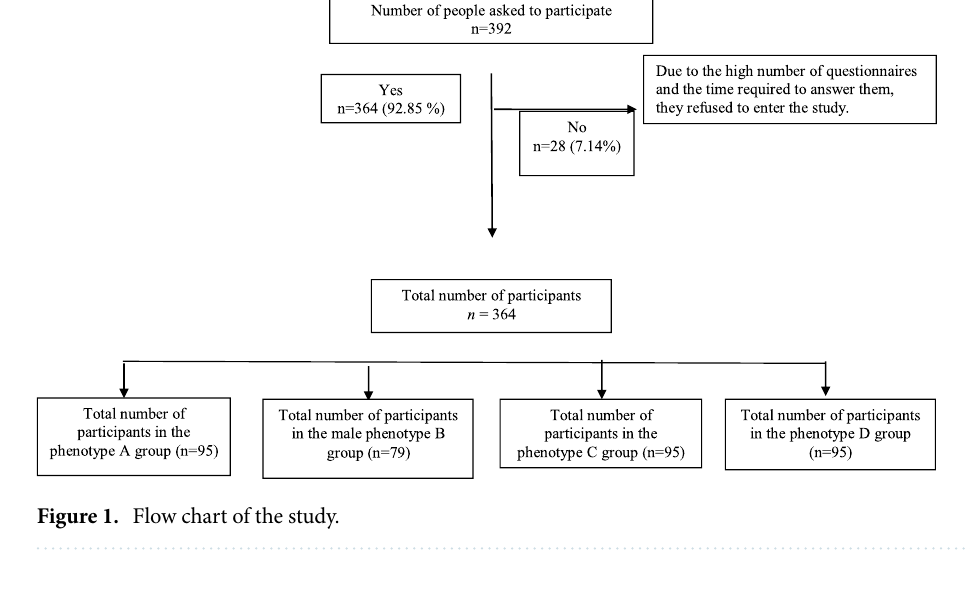
Figure 1. Flow chart of the study.